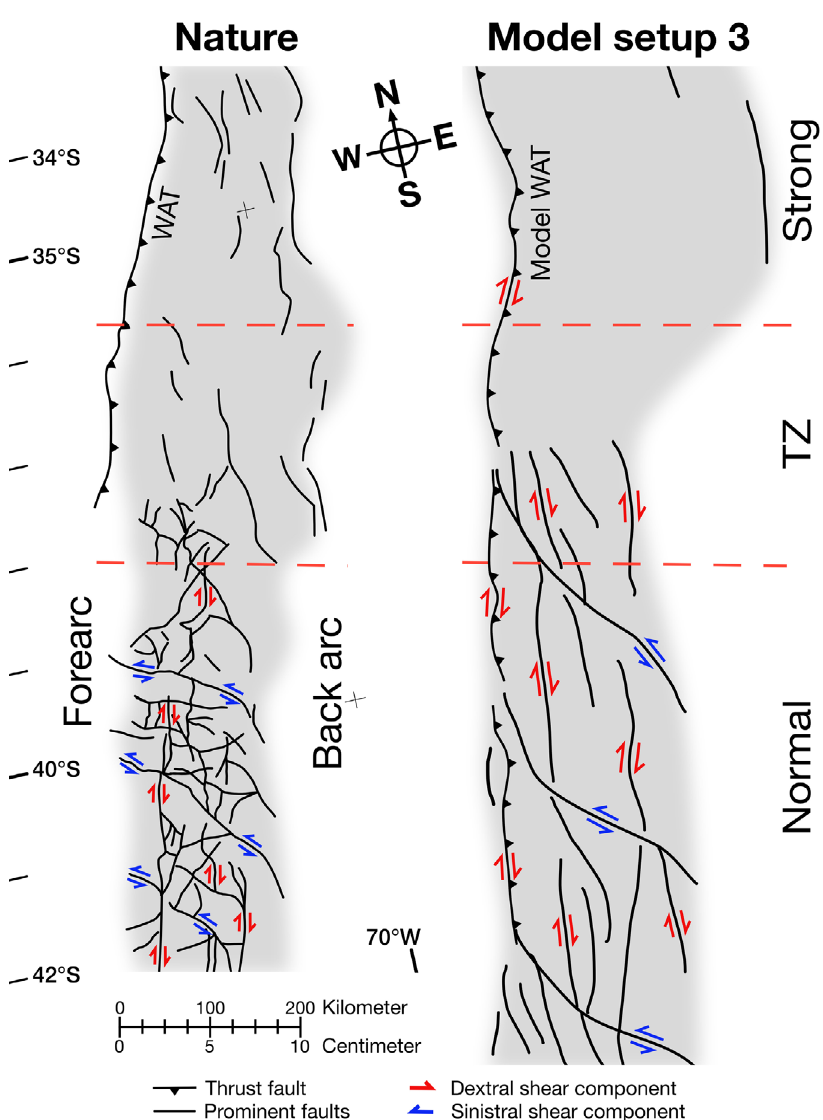
Fig. 6 Map-view traces of prominent faults in nature and model setup 3. Comparison of compiled fi rst-order fault pattern of the SVZ between 34 °S and 43 °S with fault pattern of setup 3 experiments scaled to nature. Note the structural similarity between the two patterns. TZ indicates the transition